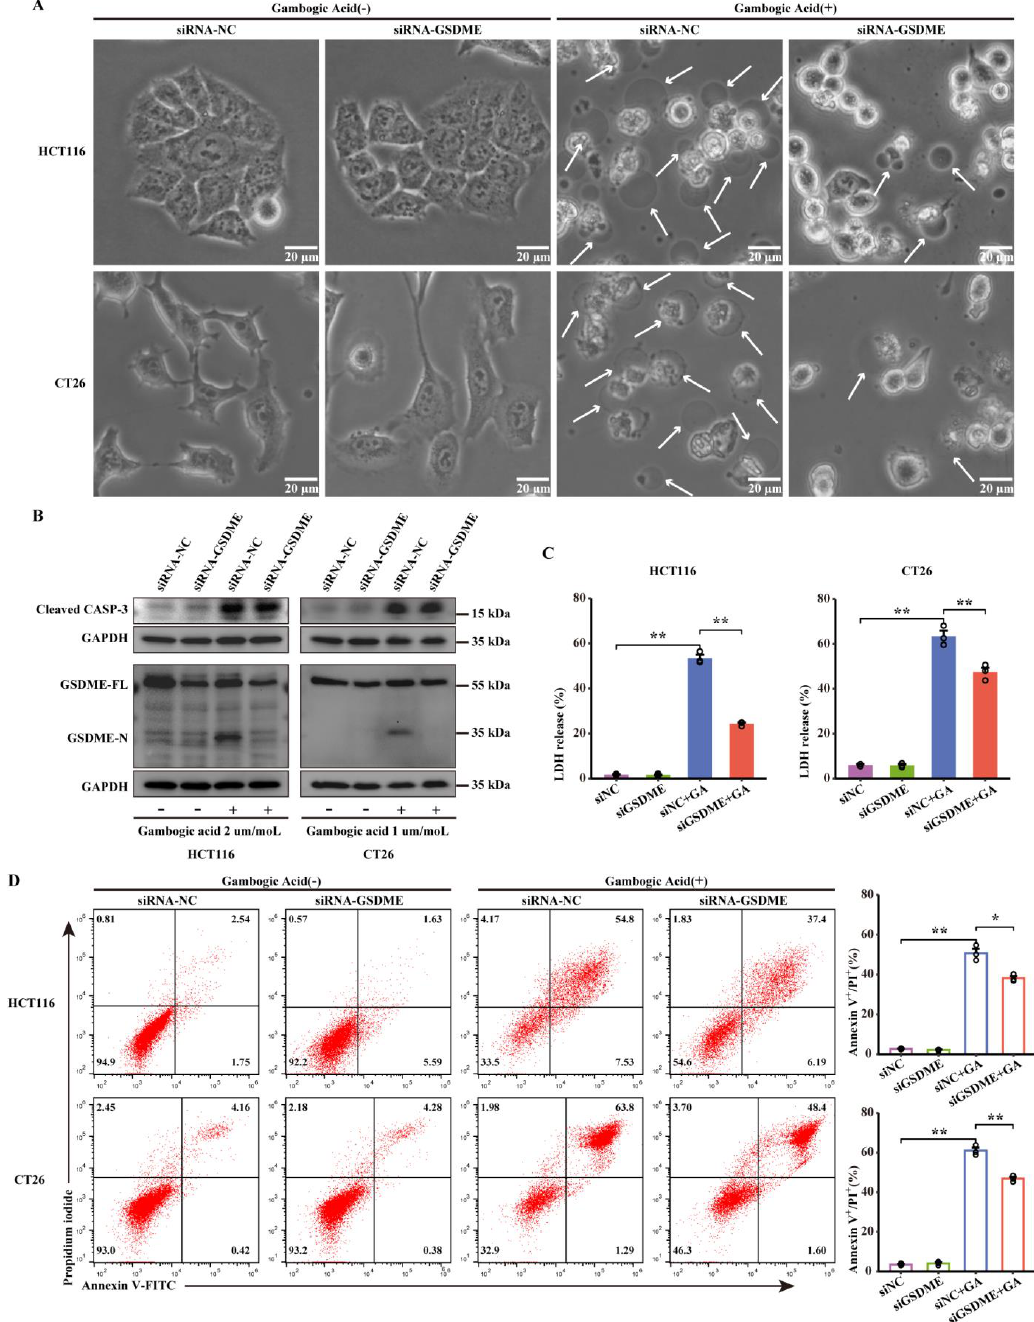
Figure 5. GSDME mediated pyroptosis of CRC cells in response to GA treatment. HCT116 and CT26 cells were transfected with siGSDME or siNC and then treated with GA (2 µ mol/L or 1 µ mol/L) for 12 h. ( A ) SiNC- or siGSDME-infected HCT116 and CT26 cells were treated with GA, and representa- tive bright-field images were obtained. The white arrows point to pyroptotic cells. ( B ) Expression of GSDME and cleaved caspase-3 in siNC- or siGSDME-transfected HCT116 and CT26 cells treated with GA analysed by western blotting. The whole western blots were shown in Figure S4. ( C ) The release of LDH and ( D ) flow cytometric analysis were performed after treatment with GA. The cells were exposed to 0.1% DMSO as control. All experiments were repeated three times and results were expressed as mean ± SD. NC, negative control. * p < 0.05 vs. control, ** p < 0.01 vs.